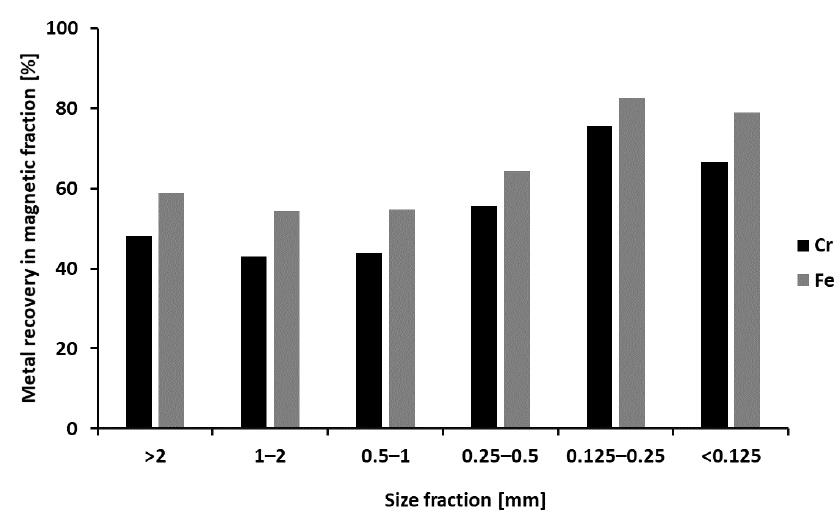
Figure 9. Recovery of Cr and Fe after magnetic separation of HC FeCr slag in M1 fraction.